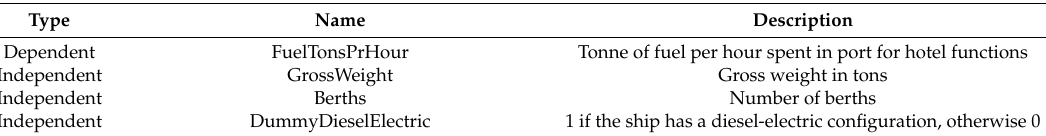
Table 2. Multivariate regression model for hotel functions.